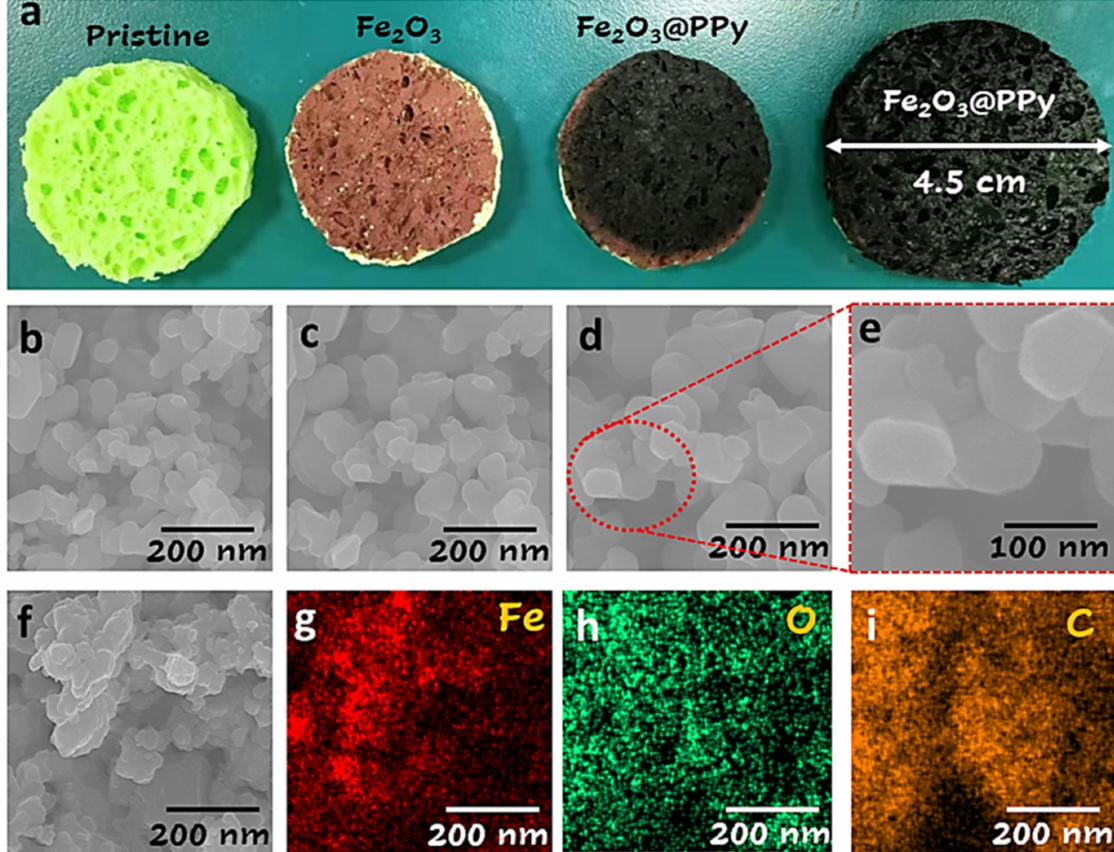
Figure 3. ( a ) Photograph of the step-by-step preparation of Fe 2 O 3 @PPy solar evaporator with various sizes. ( b – f ) Fe 2 O 3 nanoparticles under different resolutions. ( f – i ) EDS mapping of Fe 2 O 3